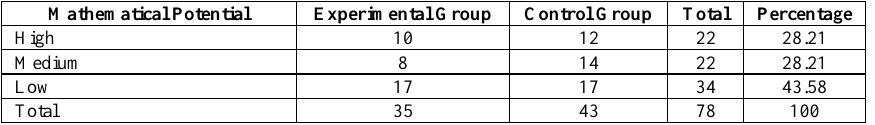
Table 1. Mathematical Potential of Sample